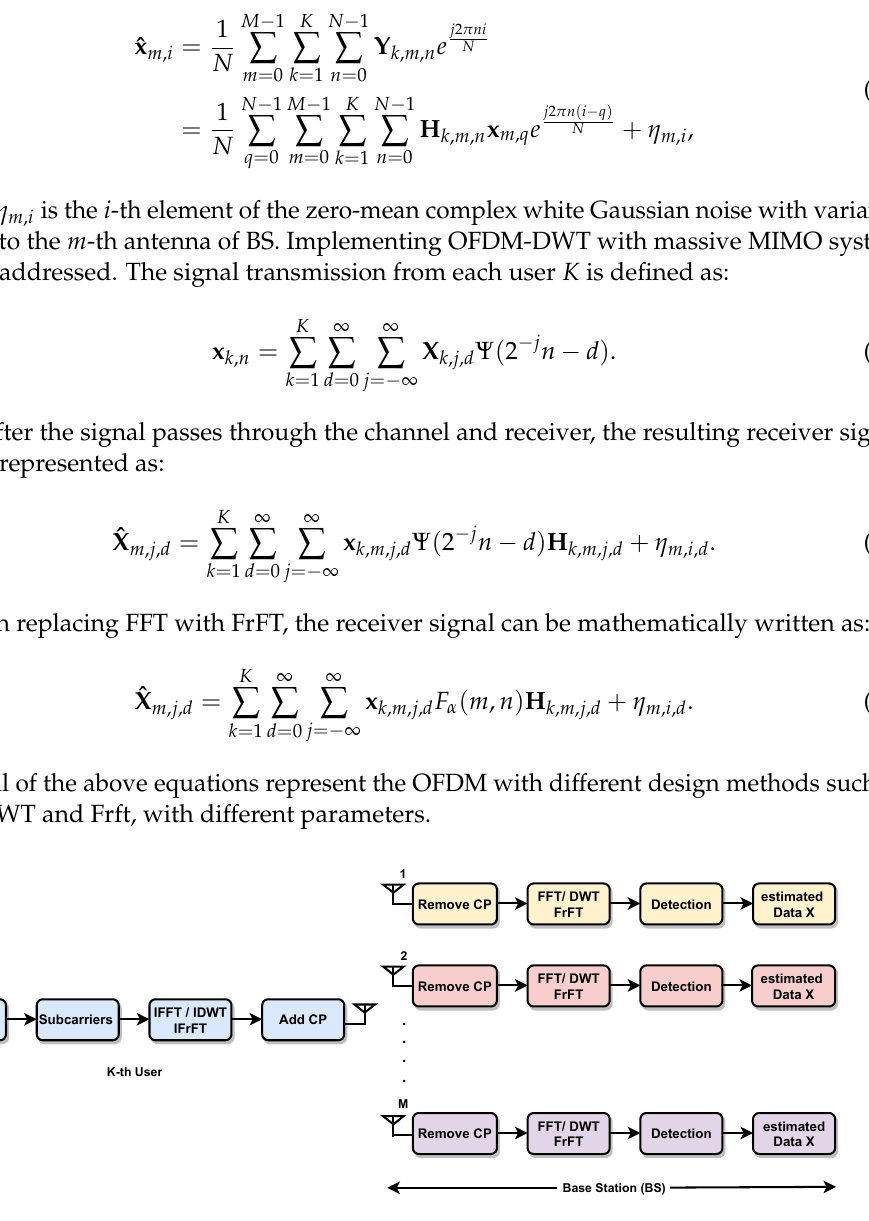
Figure 2. Block diagram of OFDM Massive MIMO systems in the